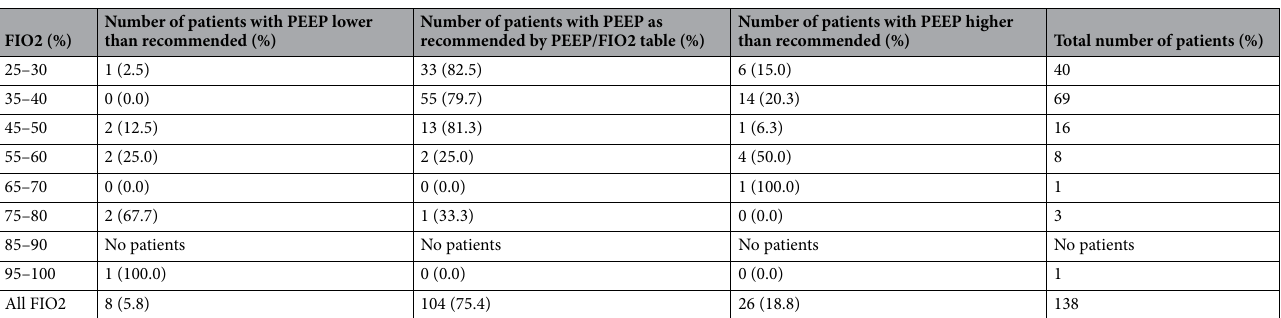
Table 3. Adherence to low PEEP/FIO2 table. FIO2 Inspired oxygen fraction, PEEP Positive end-expiratory pressure.